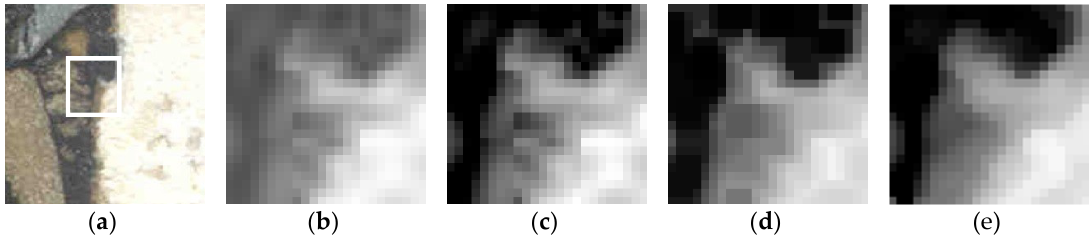
Figure 5. A series of image enhancements: ( a ) an asphalt mixture image; ( b ) gray-scale image of rectangular region in the asphalt mixture image; ( c ) equalizing image; ( d ) low pass filtering image; ( e ) median filtering image.